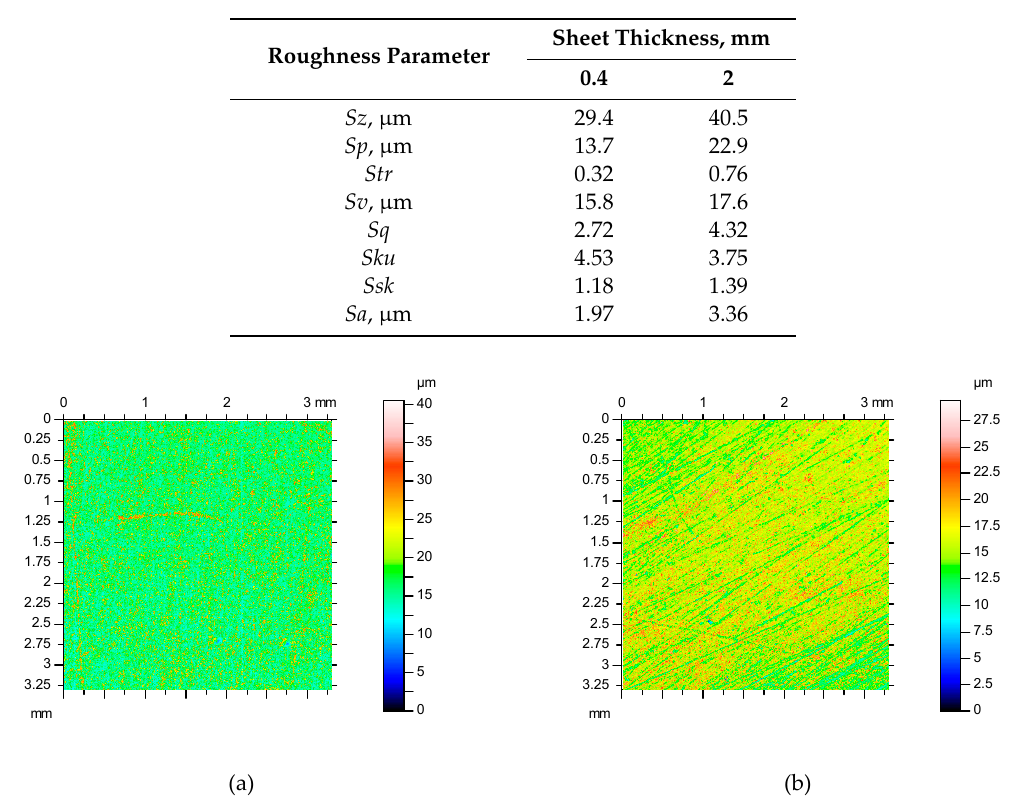
Figure 2. 2D profiles of measured sheets with thicknesses of ( a ) 2 mm and ( b ) 0.4 mm.